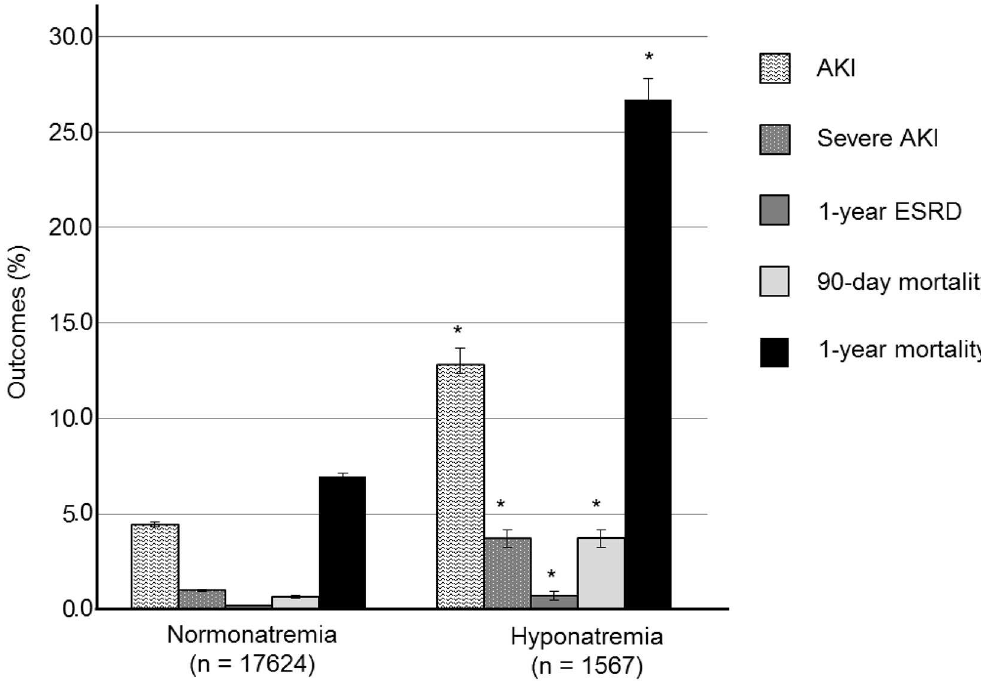
Fig 2. Clinical outcomes according to sodiumgroup. * means P < 0.001comparedto normonatremia group. Errorbar indicates standarderror. AKI, acute kidney injury;ESRD, end stage